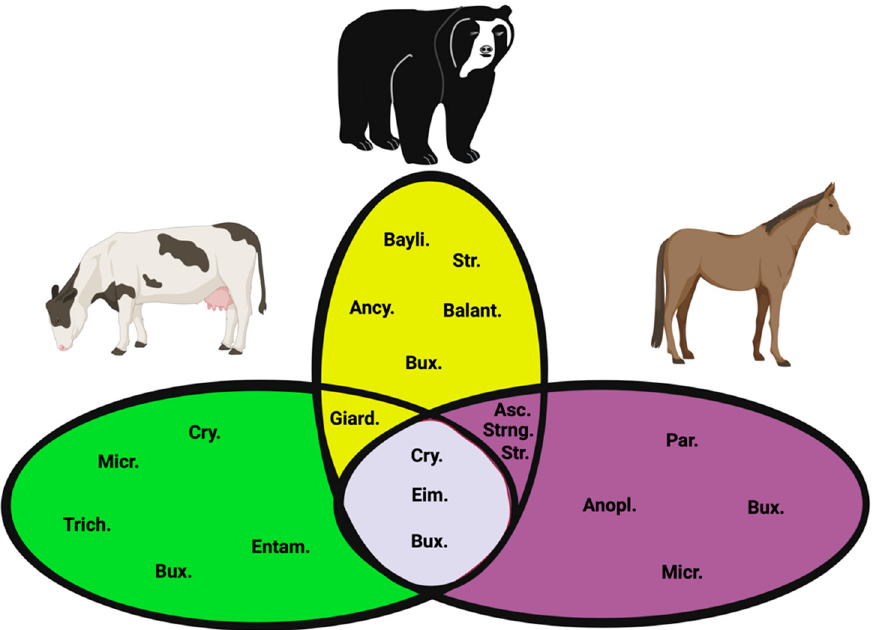
Figure 6. Endoparasites between domestic animals and T. ornatus . Eim: Eimeria spp., Cry: Cryptosporidium spp., Giard: Giardia spp., Micro: Microsporidium spp., Trich: Trichostrongylus spp., Entam: Entamoeba spp., Str: Strongyle; Taenia: Taenia spp., Bux: Buxtonella sulcata , Par: Parascaris equorum , Strng: Strongyloide spp., Asc: Ascaris lumbricoides, Ancy: Ancylostoma spp., Bayli: Bailisascaris spp., Balant: Balantidium coli